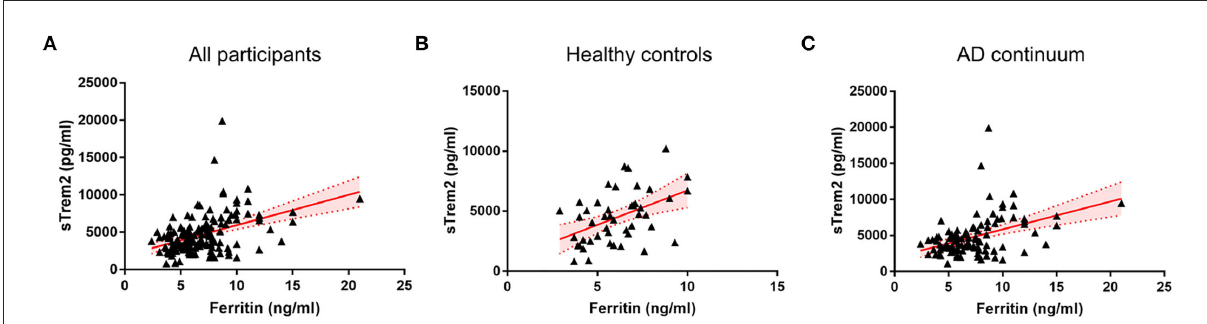
FIGURE1 The associations of CSF ferritin with sTrem2 among all participants (A) , healthy controls (B) , and AD continuum (C) . AD, Alzheimer’s Disease; CSF, cerebrospinal fluid.